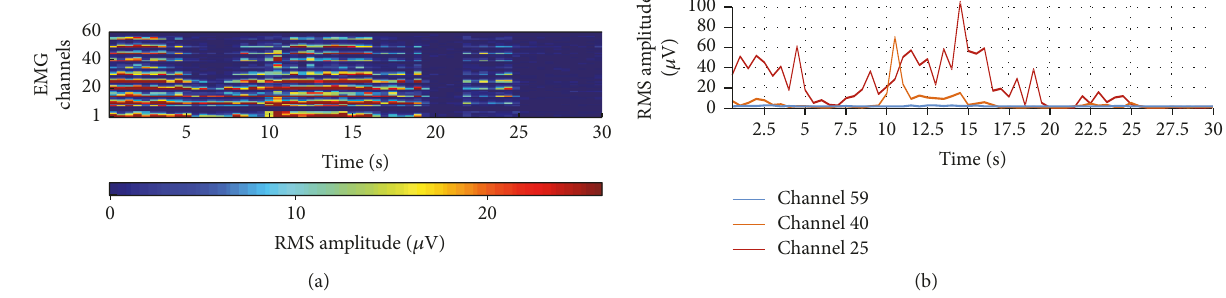
Figure 1: Surface EMG amplitude of the wrist extensors in a PD patient during rest condition. Electrode location greatly influences the EMG characterization of tremor. Tremor amplitude computed from the surface EMG using standard methods was highly variable across 60 bipolar channels of single-differential EMG (recorded with an array of 5 × 13 electrodes with interelectrode distance of 8 mm); for example, it ranged from severe tremor in channel 25 to no tremor in channel